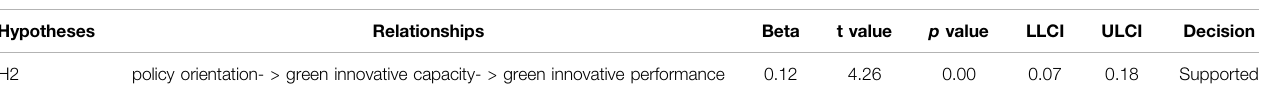
TABLE 5 | Indirect effects in the mediation model.